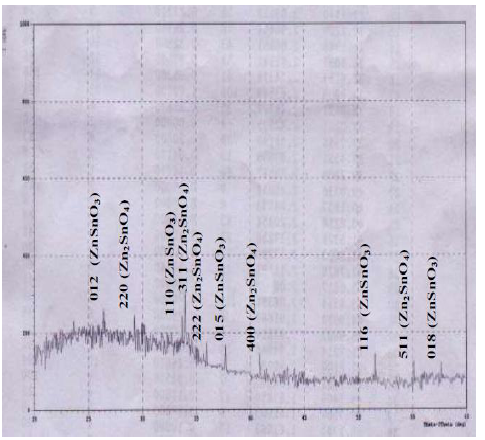
Fig.4: XRD Spectra of Z